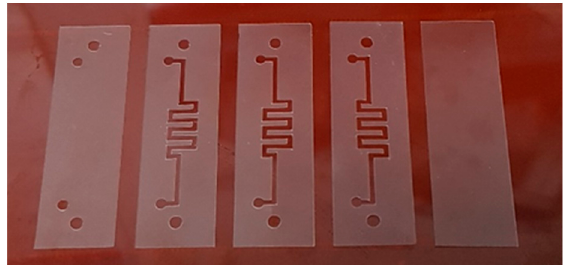
Figure 3. Separate layers of PVC foils: one top layer, three middle layers with microfluidic channel, and bottom layer as a substrate .